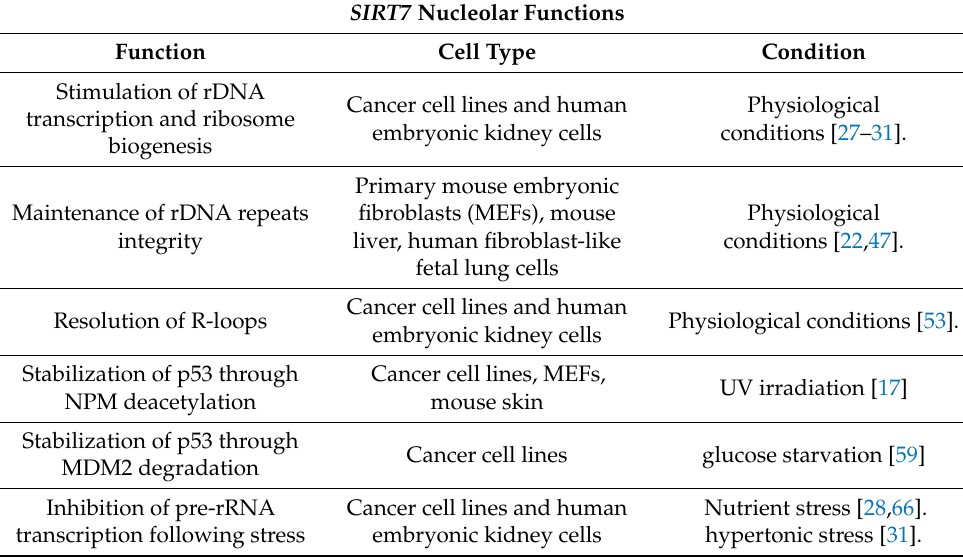
Table 1. Table summarizing SIRT7 nucleolar functions under physiological and stress